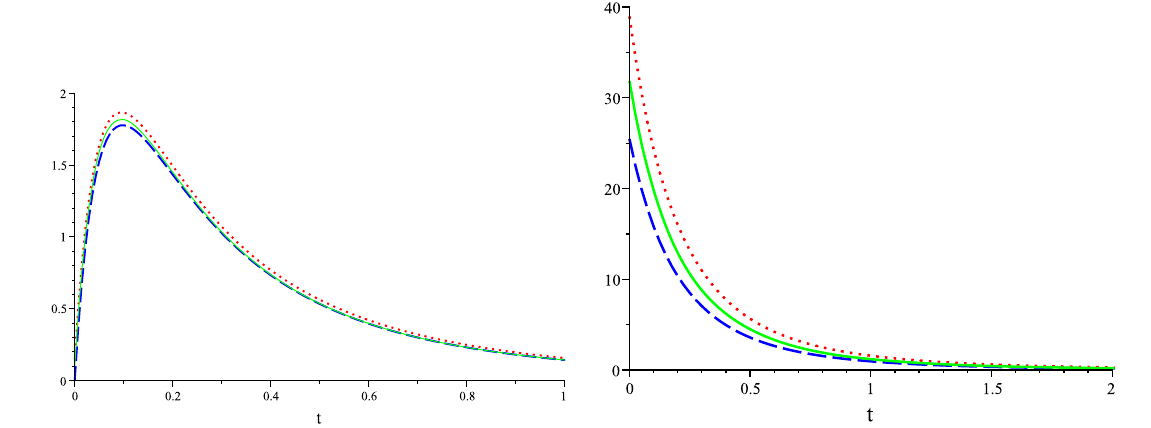
Fig. 4 The behavior of ρ , ρ + p t and ρ + p r with respect to t at throat r 0 = 2 for the left figure and at r = 5 for the right figure from up to down, respectively. The constants are chosen as α = 1, r 0 = 2 and w = − 3 / 4 in 5-dimensions